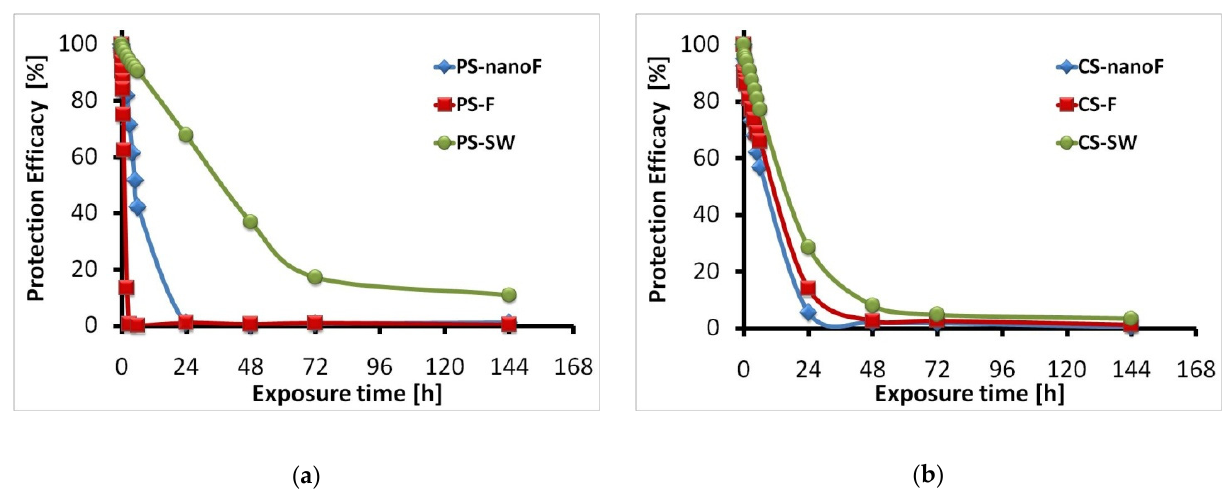
Figure 4. Protection efficacy (PE) against capillary water absorption as a function of exposure time measured on: ( a ) porous stone; ( b ) compact stone.